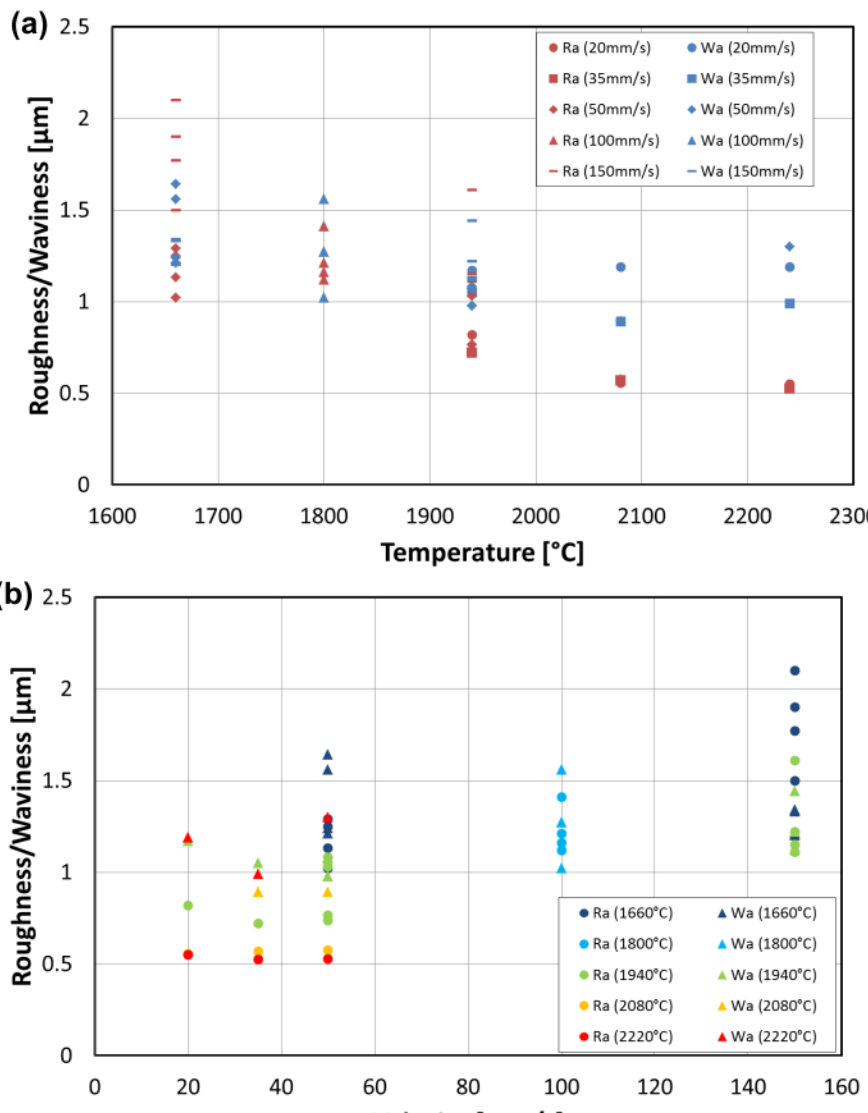
Figure 11. Evolution of the waviness and roughness as a function of ( a ) temperature and ( b ) velocity.